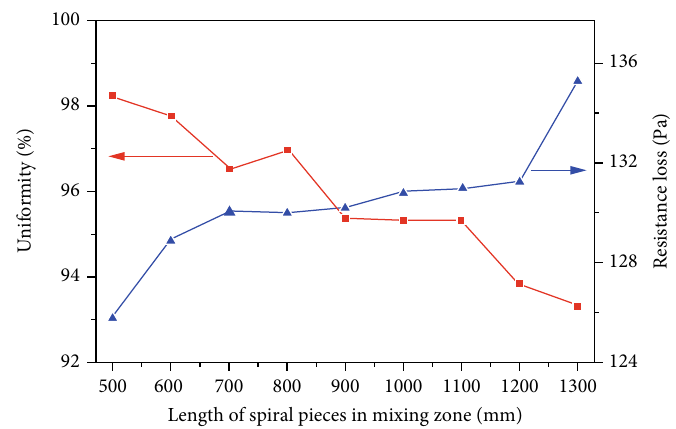
Figure 6: In fl uence of length of spiral blade on fl ow parameters in mixing zone.